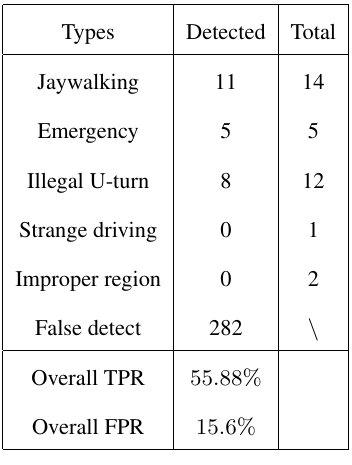
Table 1: Summary of discovered abnormal events. Overall true positive (TPR) and false positive rates (FPR) are also